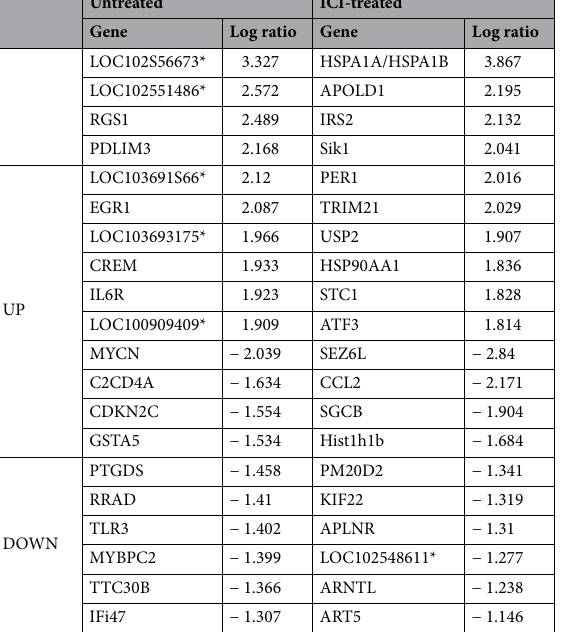
Table 1. Most disregulated genes identified in the heart by the Ingenuity Pathway Analysis based on the comparison of stressed with non-stressed untreated rats (4 rats/group), and those stressed and unstressed treated with ICI118,551 (4 rats/group). The disregulated genes were ranked according to experimental log ratio. Thresholds were based on extent of fold change (≥ 2) and p value ≤ 0.05. The lists with additional information are available in Supplementary Tables S1 and S2. *Non-annotated genes.